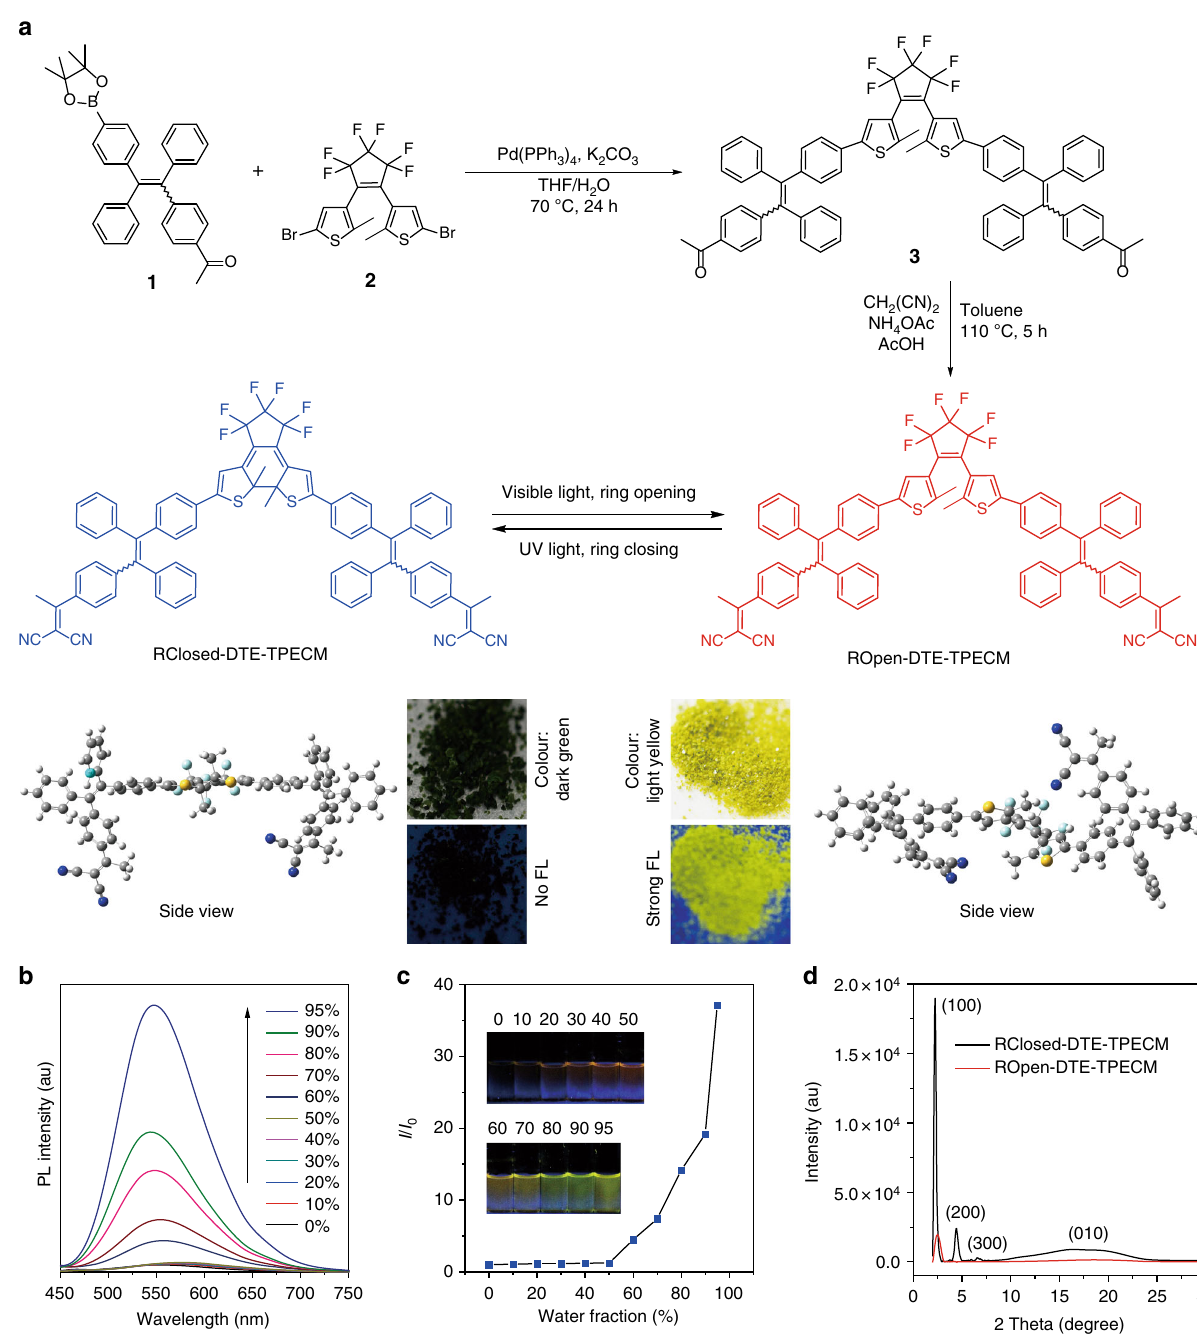
Fig. 1 Synthesis, structure and property of photo-controllable DTE-TPECM molecules. a Key synthesis steps, photo-controlled reversibility and optimized geometric structures of DTE-TPECM molecules. Photographs of ROpen-DTE-TPECM and RClosed-DTE-TPECM powders in daylight and under UV light (365 nm). FL: fl uorescence. b PL spectra of ROpen-DTE-TPECM in THF/water mixture with various water fractions. c Plot of I / I 0 versus water fraction. I 0 and I are the peak PL intensities of ROpen-DTE-TPECM (10 μ M) in pure THF and THF/water mixtures, respectively. Inset shows the photographs of ROpen-DTE-TPECM in THF/water mixtures with different water fractions taken under UV illumination. d XRD diagrams of ROpen-DTE-TPECM and